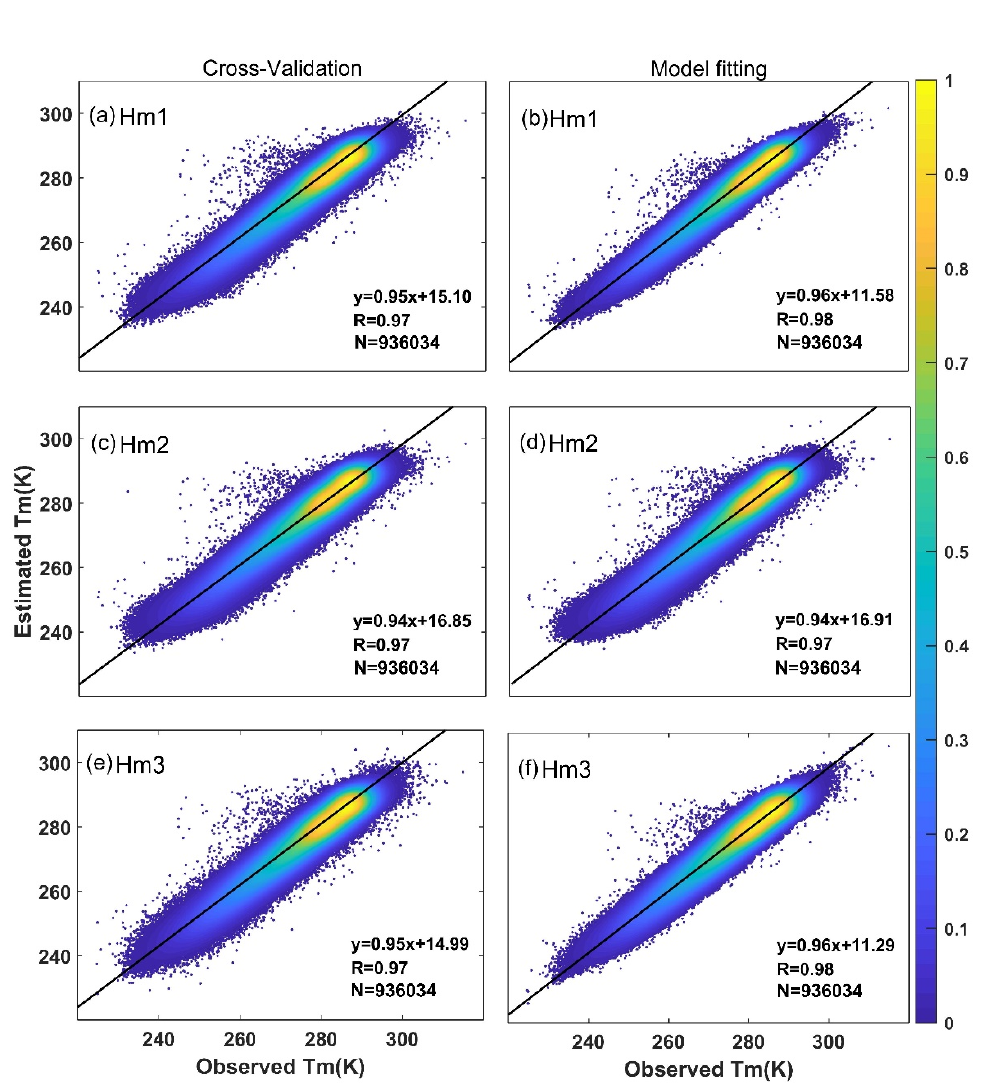
Figure 6. Scatter plots of estimated T m against T m derived from radiosonde data for different models: